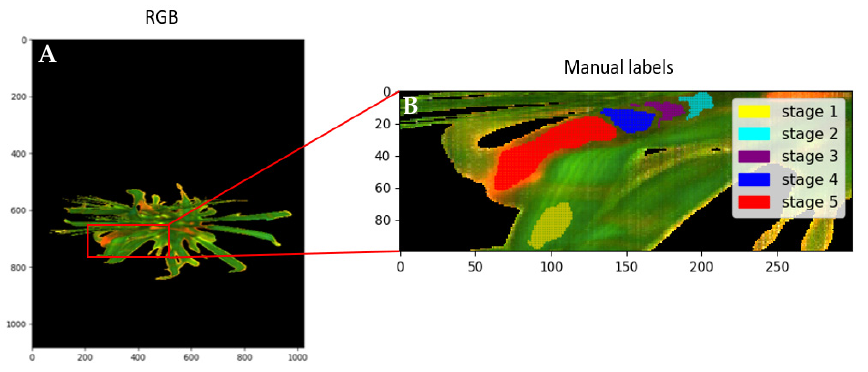
Figure 2. Red, green, and blue (RGB) representation of a hyperspectral image after preprocessing and soil and background removal. The red square ( A ) shows the region of interest (ROI) that was used to manually label a relatively small training dataset for a comparison with the automatic labelling algorithm. This ROI is enlarged in the image on ( B ).